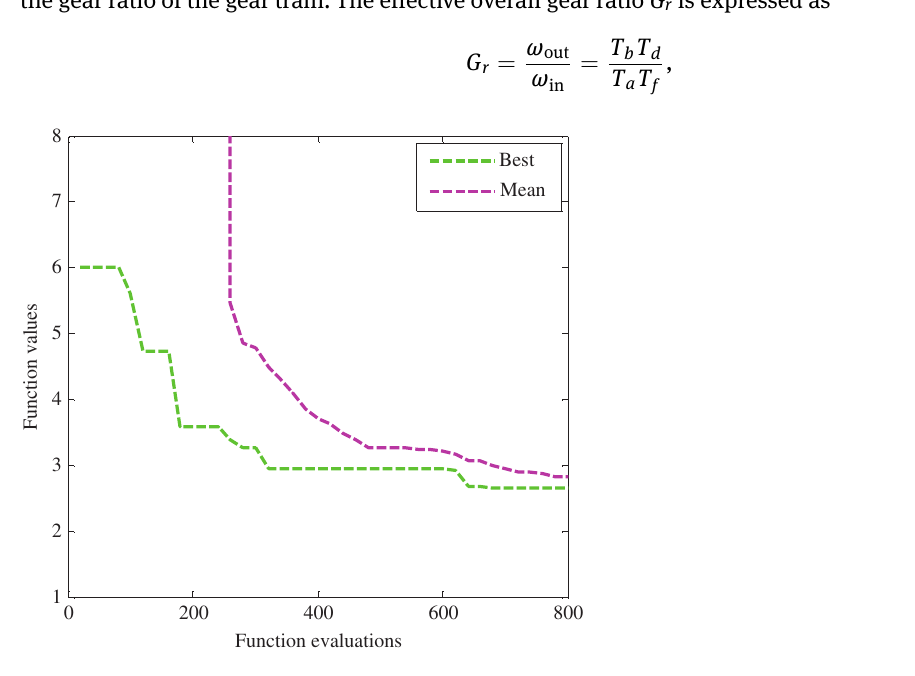
Figure 9: Convergence Characteristic of Objective Function for Spring Design. Table 4: Optimal Solutions Comparison for the Spring Design. Design variables ( x